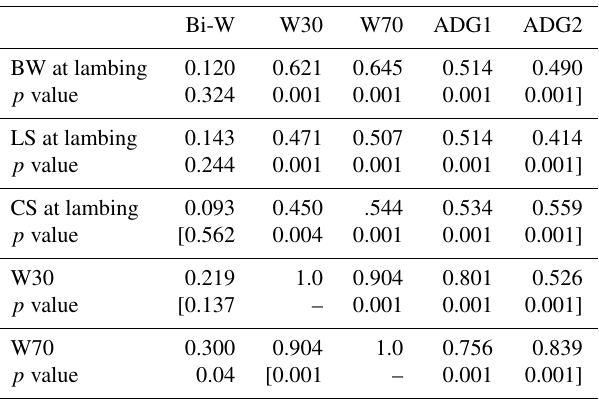
Table 5. Correlation coefficients among ewes’ body weight (BW), lumbar (LS) and caudal (CS) at lambing and lamb growth parame- ters. Bi-W W30 W70 ADG1 ADG2 BW at